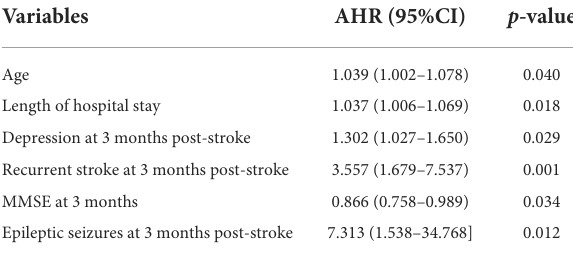
TABLE 8 Independent predictors of 1-year any-cause of death using cox proportional hazard regression multivariable